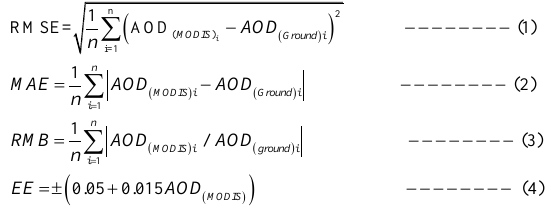
expected error (EE) at all ground observational